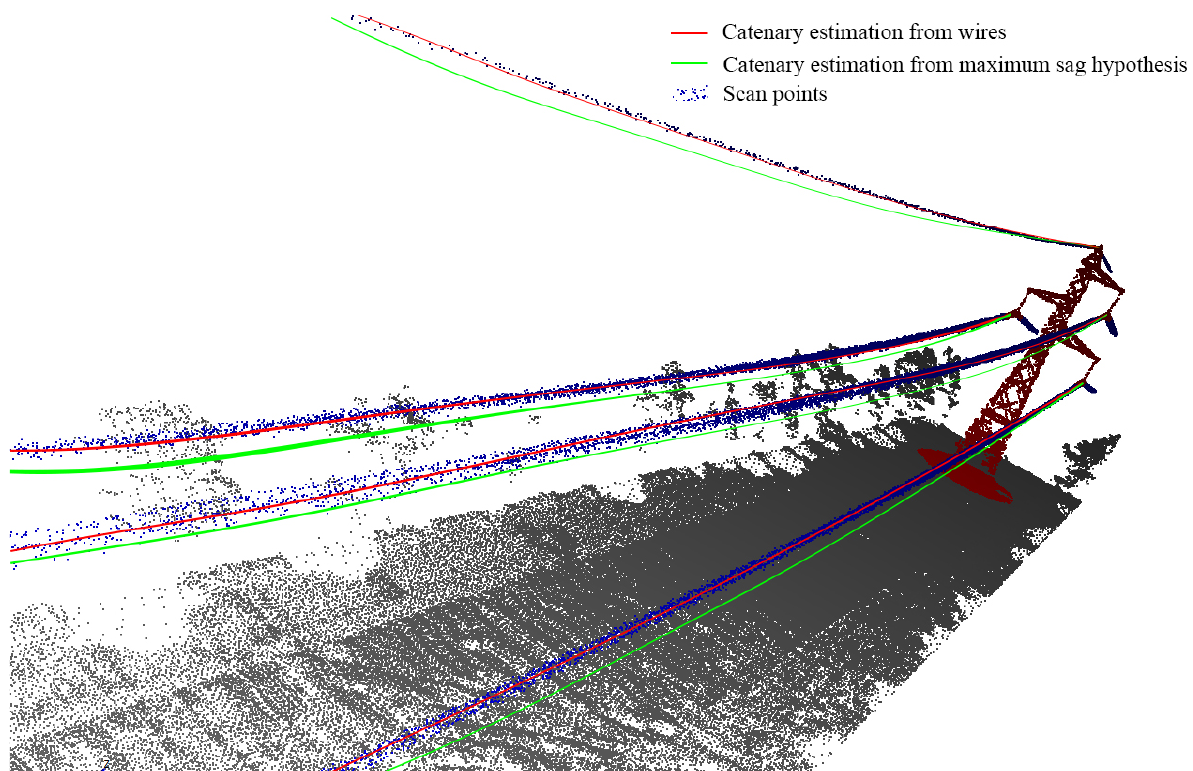
Figure 3. Wire catenary estimation from wire geometry (red) and theoretical maximum sag hypothesis (green). Points classified as cable groups in blue and points classified as pylons in red.